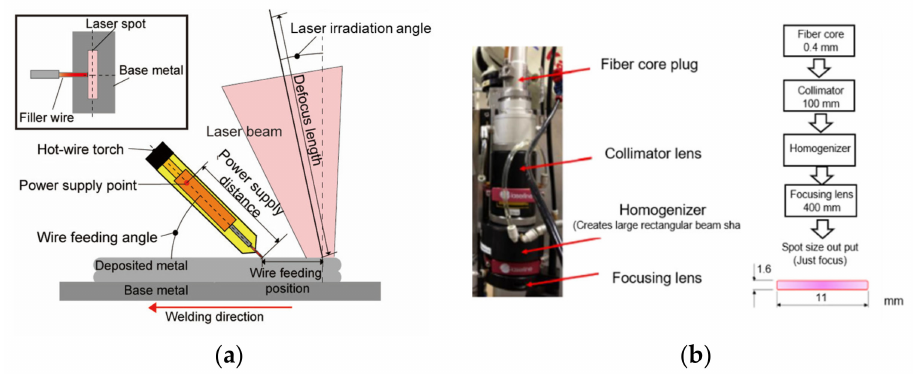
Figure 1. HLAM experimental setup: ( a ) schematic diagram of HLAM process; ( b ) laser head and beam